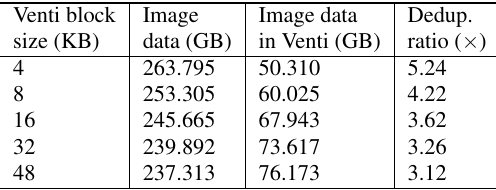
Table 2: The effect of different Venti block sizes for deduplicating disk data. These storage figures are for disk data only, and do not account for image metadata.